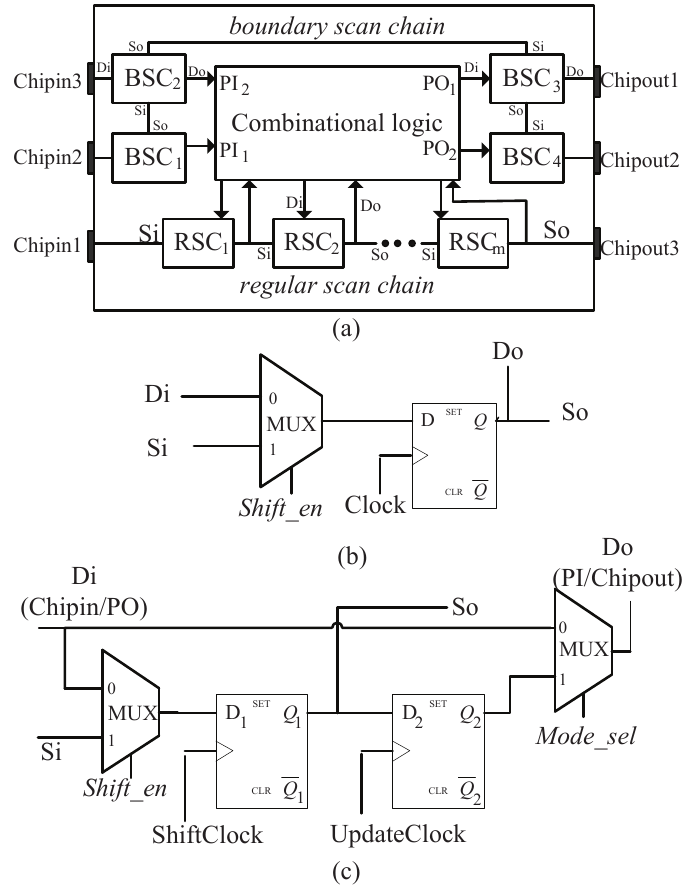
Figure 1. Scan design. ( a ) Scan architecture including regular and boundary scan chain. ( b ) Internal architecture of a RSC. ( c ) Internal architecture of a